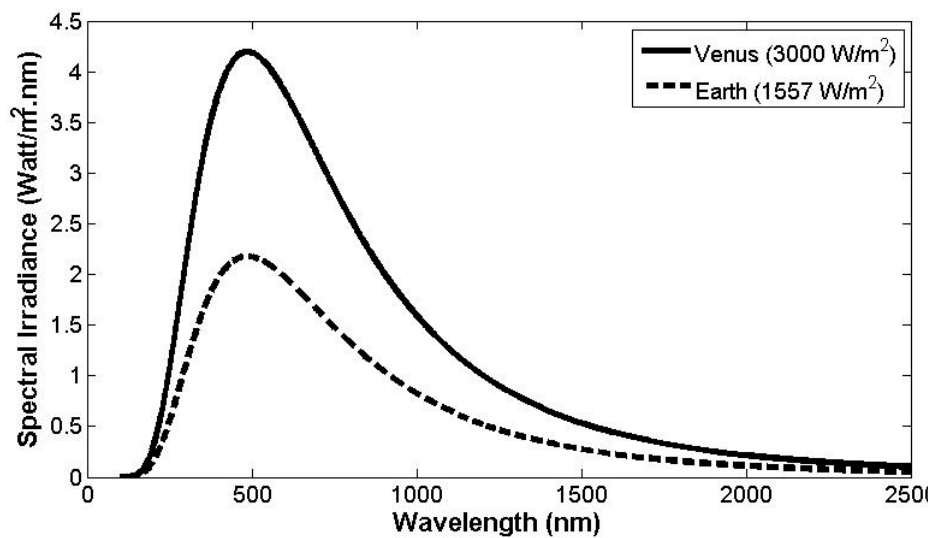
Figure 3. The incoming spectral irradiance at the geosynchronous orbit of Venus and Earth calculated using a blackbody radiation formula. The total power density (intensity) at the geosynchronous orbit of Venus is 3000 W / m 2 , while for Earth it is 1557 W / m 2 .